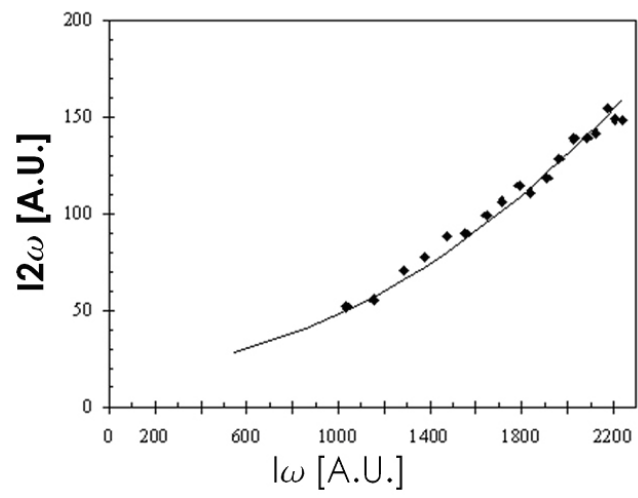
Figure 2. The Kurtz-Perry experimental data for L-leucinium